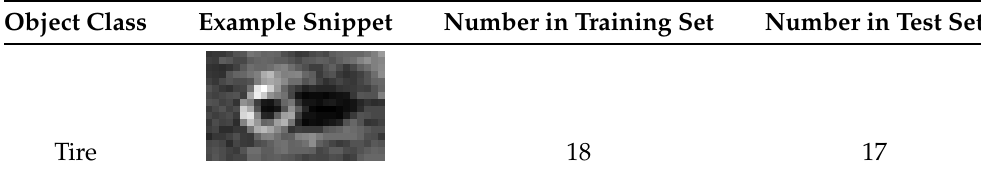
Table 1. Labeled classes and division into training and test